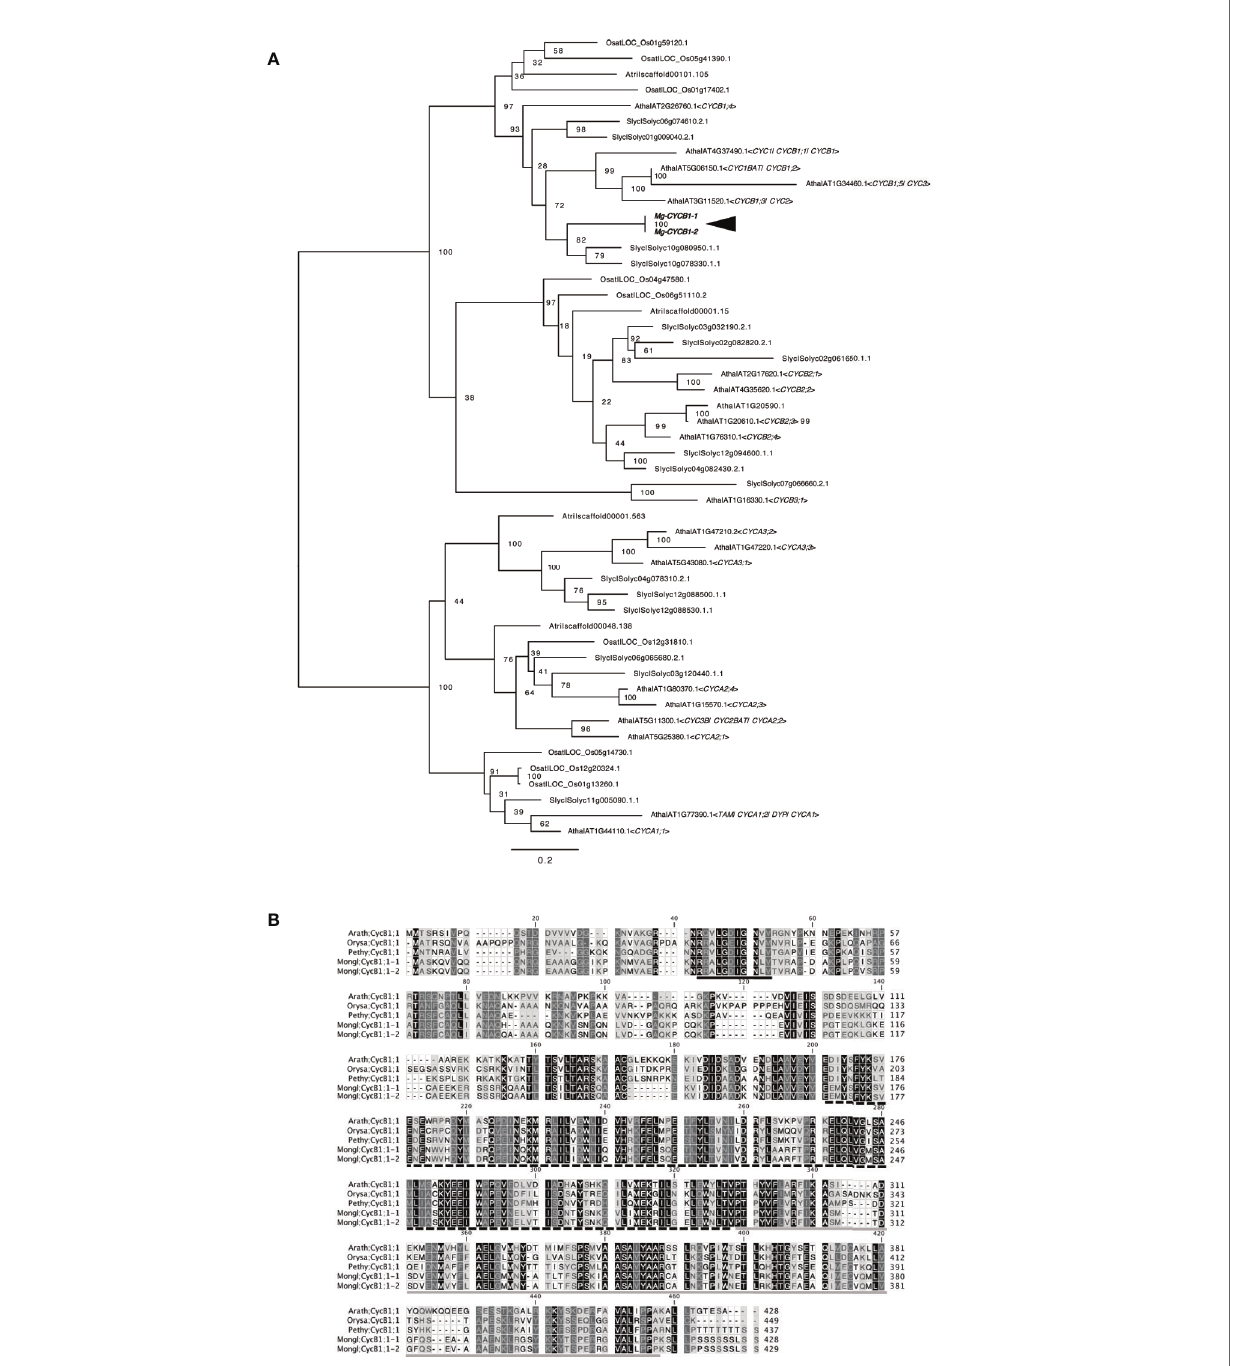
FIGURE 2 | Molecular characterisation of Mg-CYCB1 (Mongl;CycB1;1-1, Mongl;CycB1;1-2). (A) Maximum likelihood tree of cyclin amino acid sequences. Bootstrap values are shown at the branches. Amaj, Antirrhinum majus ; Atha, Arabidopsis thaliana ; Atri, Amborella trichopoda ; Osat, Oryza sativa ; Slyc, Solanum lycopersicum ; Zmay , Zea mays. (B) Amino acid sequence alignment of CYCB1 orthologs; dashes indicate gaps. The destruction box, cyclin C-terminal domain, and cyclin N- terminal domain are indicated by black, black hatched, and gray underlining, respectively. The darker background color indicates an amino acid conserved among the fi ve sequences. Arath, Arabidopsis thaliana ; Orysa, Orya sativa ; Pethy, Petunia hybrida ; Mongl, Monophyllaea glabra